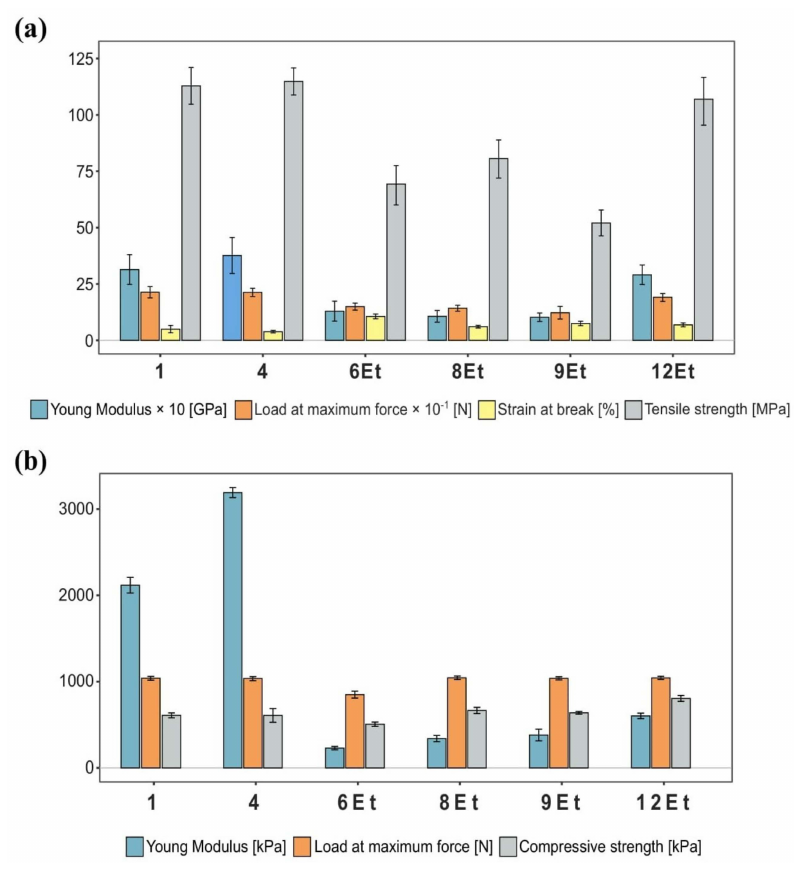
Figure 6. Mechanical parameters of BNC membranes synthesized by chosen strains. ( a ) Breaking strength measurements results, ( b ) compression tests